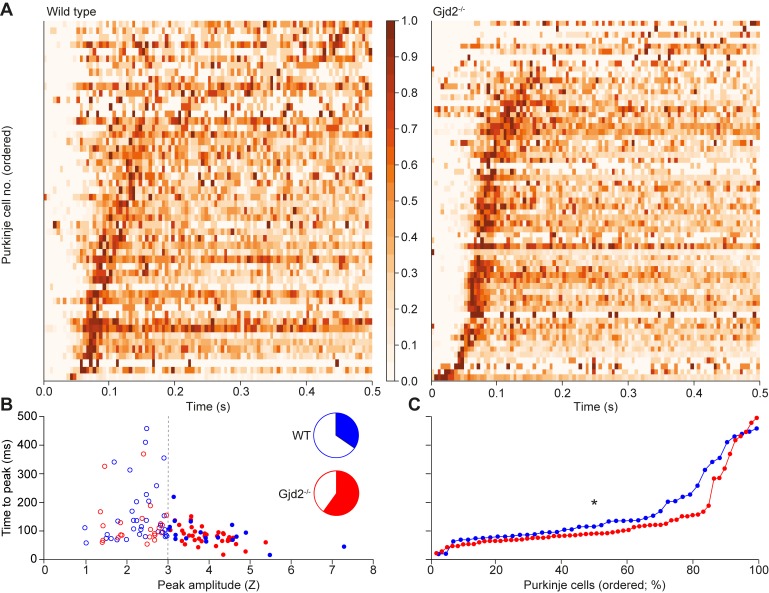
Oscillatory dynamics in spontaneous firing in vivo in the presence and absence of gap junctions.(A) Color-coded inter-complex spike-interval (ICSI) histogram of spontaneous firing of 60 Gjd2-/- and 52 wild-type Purkinje cells, normalized to the bin with the highest complex spike count per Purkinje cell. (B) The Gdj2-/- Purkinje cell distribution shows higher Z-scores than the wild-type population, indicating a stronger rhythmicity during spontaneous firing in the absence of gap junctions (p = 0.003; Kolmogorov-Smirnov test). A Z-score >3 was taken as sign for the presence of rhythmicity–which occurred more often in the Gjd2 KO than in the WT Purkinje cells (colored fraction in the pie diagrams; p = 0.005; Fisher’s exact test). In the absence of gap junctions, rhythmic firing was more stereotypical, as illustrated by less variation in the time to peak (C; p = 0.0431; U = 1030.0; Mann-Whitney test). Note that the left panel of A is a copy of Fig 2B and presented here to facilitate comparison.